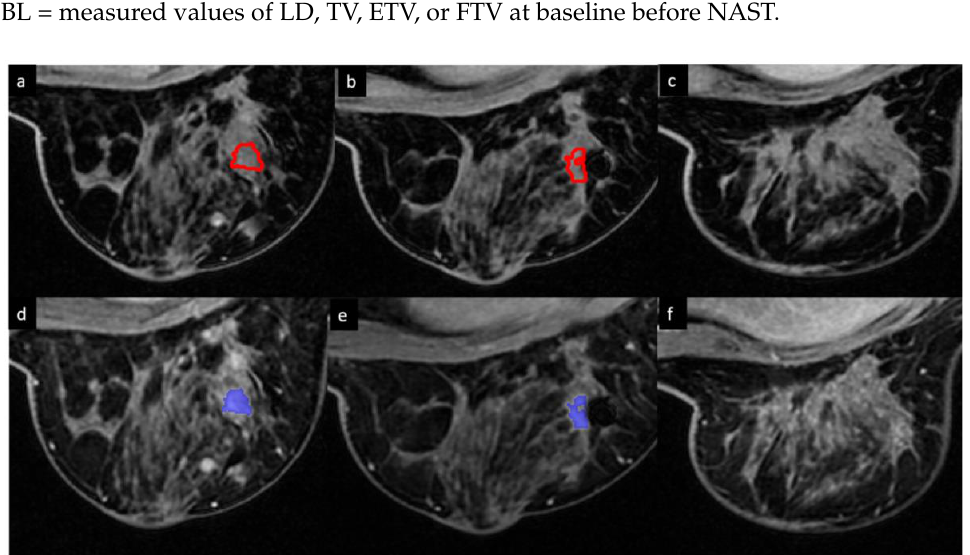
Figure 2. Enhanced tumor volumes (red) and functional tumor volumes (blue) in a 61-year-old patient with TNBC with a pathologic complete response at surgery. ( a , d ) Baseline. ( b , e ) After 2 cycles of neoadjuvant systemic therapy (NAST). ( c , f ) After 4 cycles of NAST. No segmentation was performed after 4 cycles since there was no residual tumor enhancement at that time. Functional tumor volume ( bottom row ) is the subset of enhanced tumor volume ( top row ), satisfying the PE and SER thresholds.